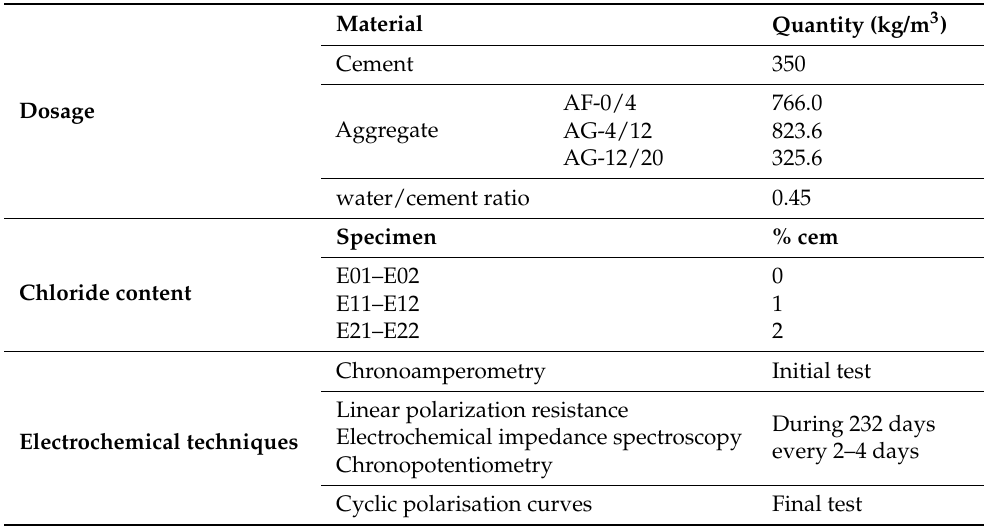
Table 2. Summary of dosage, samples, and tests